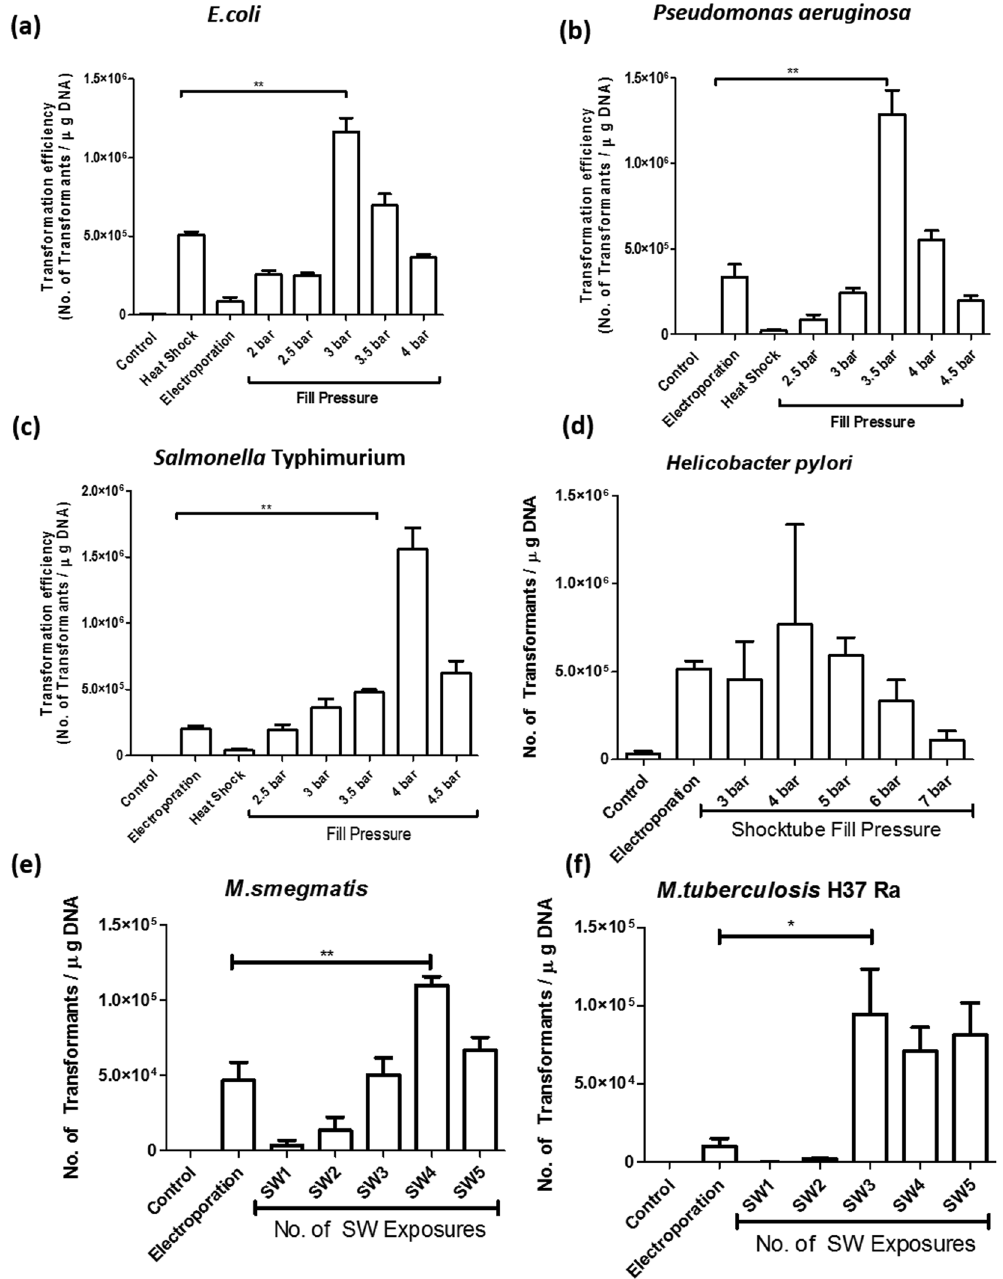
Figure 2. Efficiency of bacterial transformation using shockwaves and its comparison with electroporation. ( a ) E.coli , ( b ) P.aeruginosa , ( c ) Salmonella Typhimurium, ( d ) H. pylori , ( e ) Mycobacterium smegmatis and ( f ) Mycobacterium tuberculosis were transformed with relevant plasmids mainly by heat shock, electroporation and shock waves. After transformation LB broth was added to the cells, incubated at 37 °C for 1 h before plating. For E.coli, P.aeruginosa , Salmonella and H.pylori the shocktube fill pressure was varied. For Mycobacterial transformations, the shocktube fill pressure was maintained at 10 bar and the number of consecutive shockwave exposures were varied to achieve high efficiency transformation. Post incubation, CFU were counted and transformation efficiency was calculated. Statistical significance was defined as follows ( * P < 0.05, ** P < 0.005, *** P < 0.0005) (Student’s t